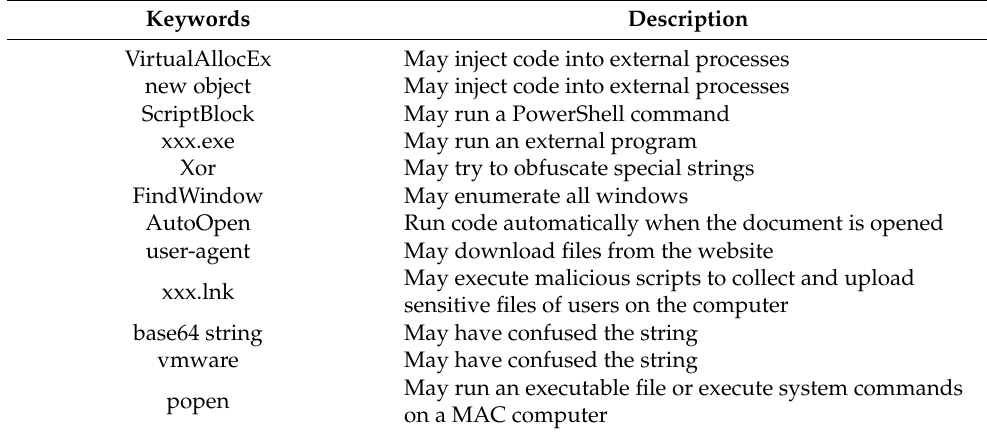
Table 3. The functions of some VBA